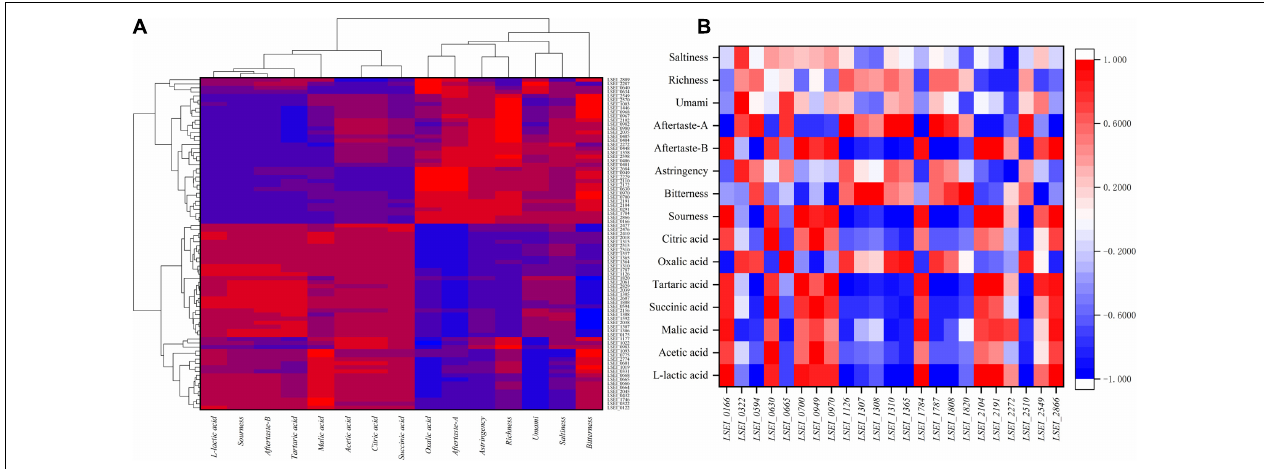
FIGURE 4 | Correlations among the characteristic flavor (organic acids and taste substances) and gene expression (A) , Correlations among the characteristic flavor (organic acids and taste substances) and the key 23 genes (B) .